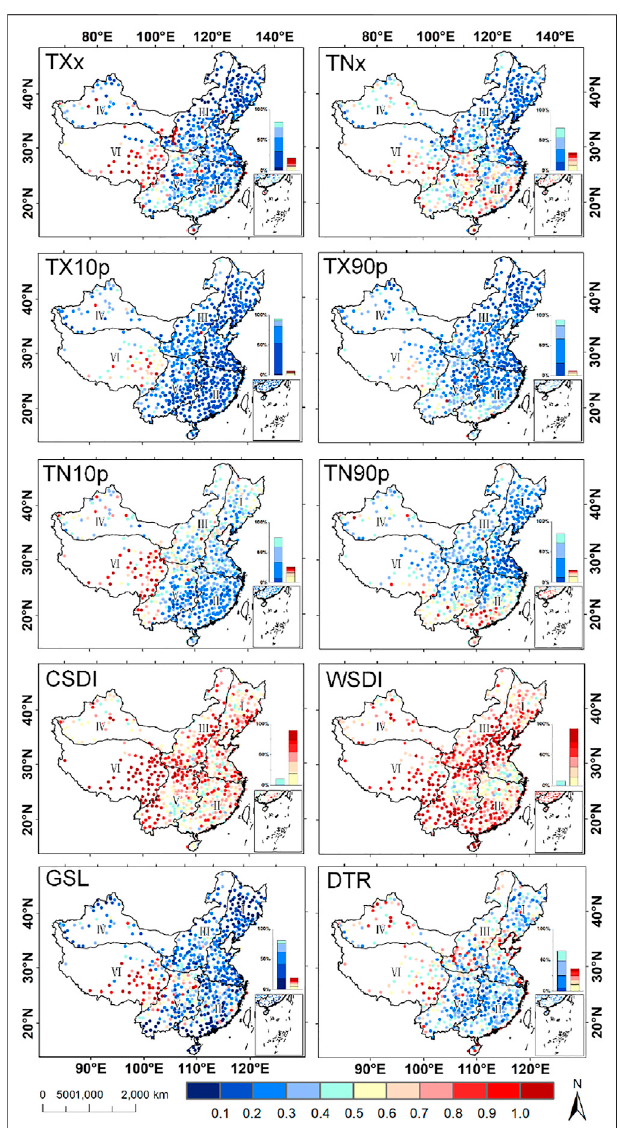
FIGURE 3 | Spatial distribution of DISO for extreme temperature indices of ERA5 over